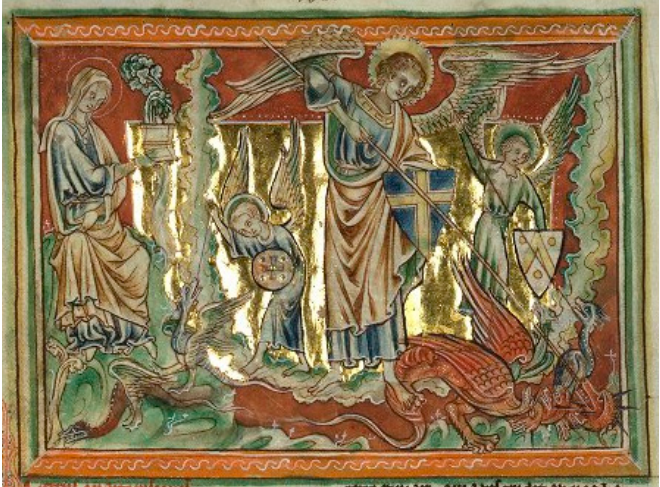
Figure 9. Lambeth Apocalypse (London, Lambeth Palace Library MS 209). Fol. 15 v , c. 1264–67, by permission of Lambeth Palace Library.